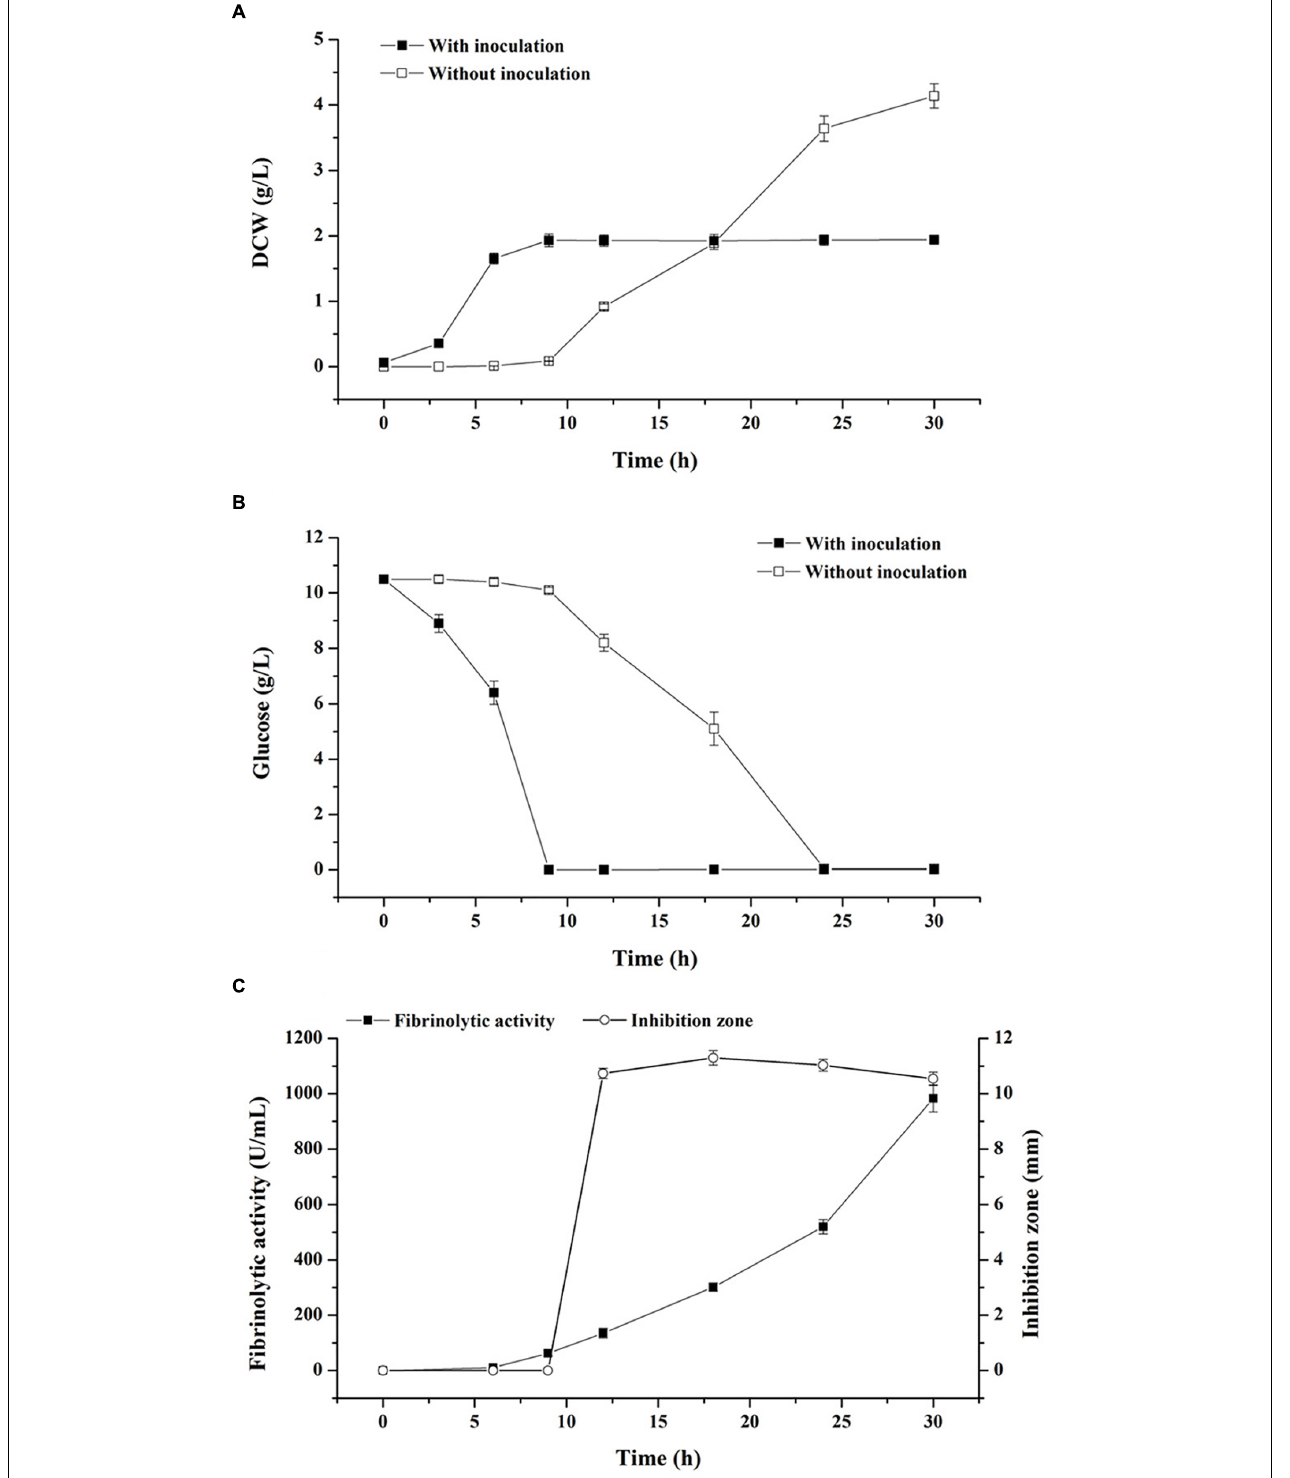
FIGURE 1 | Effects of starvation strategy and self-production of antibacterial compounds on contaminant control and fibrinolytic enzyme production. Cell growth (A) and glucose consumption (B) during fermentation using the non-sterile basal medium with and without inoculation of B. subtilis D21-8. (C) Time courses of fibrinolytic activity and antibacterial activity against E. coli DH5 α in non-sterile fermentation by B. subtilis D21-8 using the basal medium. Antibacterial activity was indicated by the diameter of the inhibition zone.